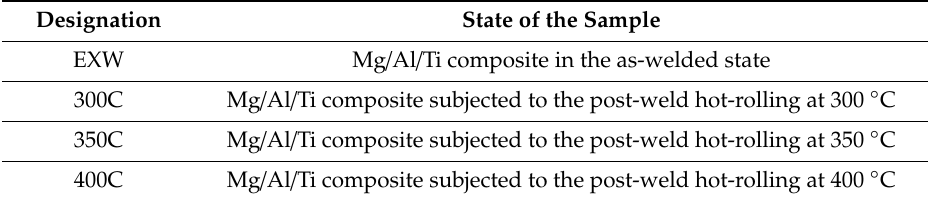
Table 2. The designation of the samples.